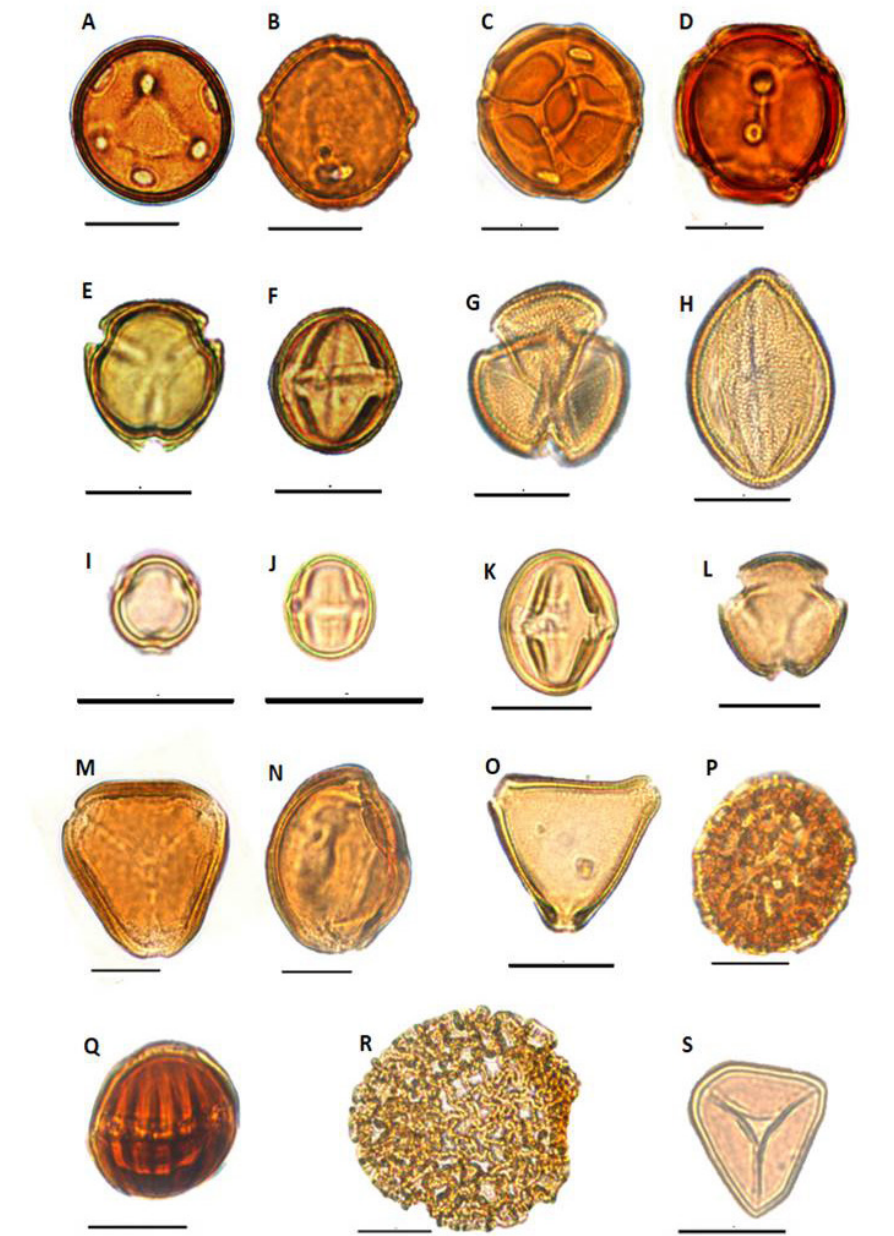
Fig 1 . Pollen types found in nests of Centris analis (Fabricius, 1804) and Centris terminata Smith, 1874 sampled from urban fragment of Atlantic Forest in Salvador, Bahia. A-B: Malpighia emarginata (Malpighiaceae) . C-D: Stigmaphyllon cavernulosum (Malpighiaceae). E-F: Cestrum axillare (Solanaceae) . G-H: Handroanthus chrysotrichus (Bignoniaceae). I-J: Byrsonima sericea (Malpighiaceae). K-L: Aeschynomene paucifolia (Fabaceae) . M-N: Dioclea grandiflora (Fabaceae).O: Serjania type (Sapindaceae). P: Delonix regia (Fabaceae). Q: Securidaca diversifolia (Polygalaceae) . R: Amphilophium crucigerum (Bignoniaceae) . S: Elaeis guineensis (Arecaceae). (Bar scale =